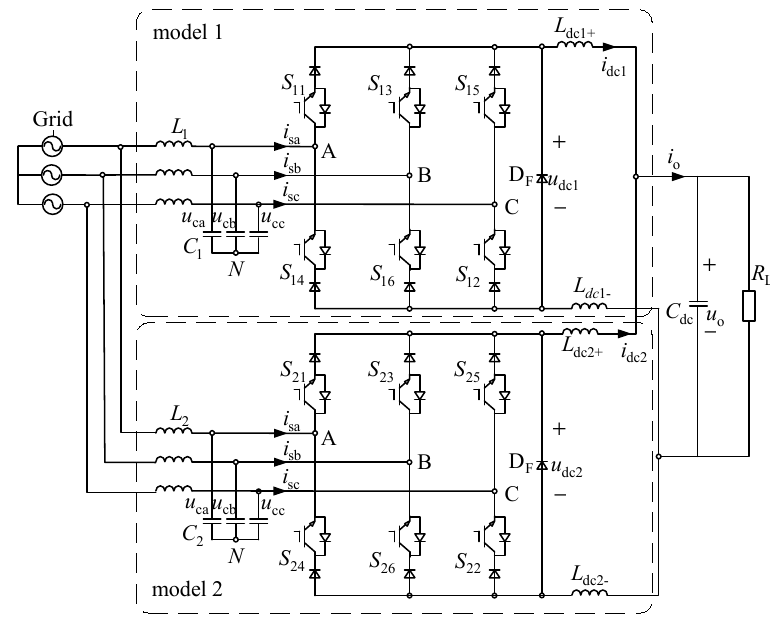
Figure 4. Topology of two current source converters in parallel.